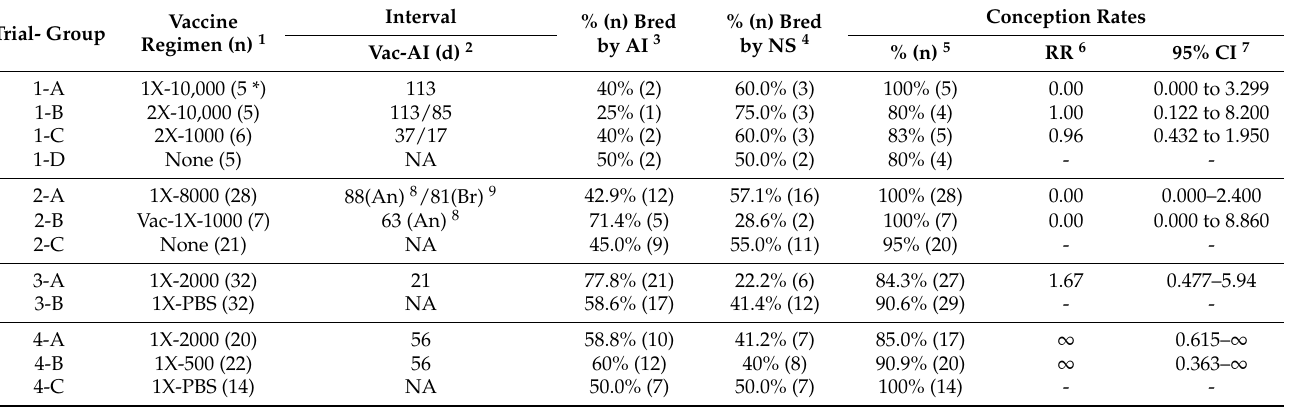
Table 1. Study design and conception rates.